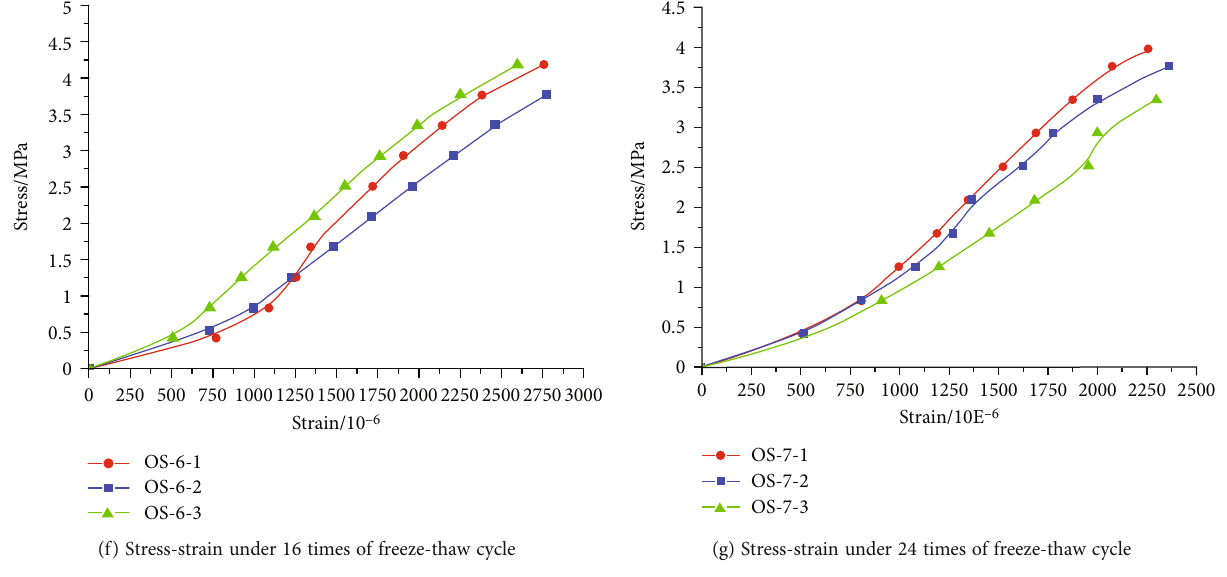
Figure 9: Variation of freeze-thaw cycles on the stress and strain of the measured oil shale Table 4: Relationship between the freeze-thaw coe ffi cient and freeze-thaw cycles. Fresh and dry Fresh and saturated